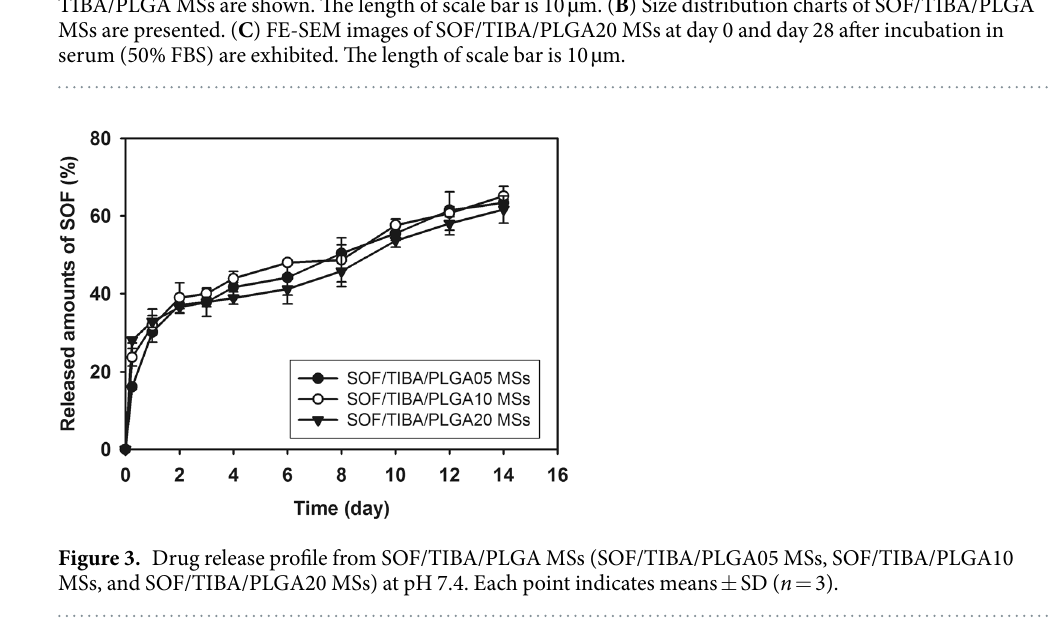
(Fig. 6). In the oral administration group, the ratios of drug concentrations in the liver tumor compared to the normal liver on days 3 and 7 were 0.18 and 0.25, respectively. However, those ratios in the IA administration group on days 3 and 7 were 33.00 and 6.66, respectively. In spite of a lower dosing frequency and administration dose in the SOF/TIBA/PLGA20 MSs group (IA administration) compared with the SOF solution group (oral administration), the distribution ratio (liver tumor to normal liver) of SOF was significantly higher in the SOF/ TIBA/PLGA20 MSs group than in the SOF solution group.